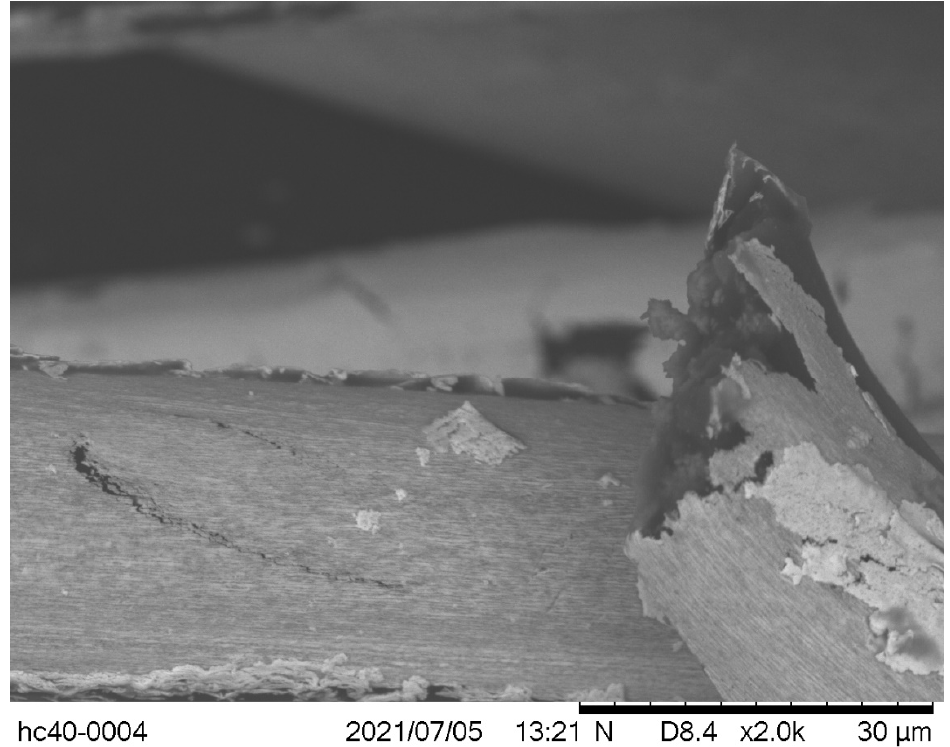
Table 2. Goodness of fit data per fitted line and thread type.